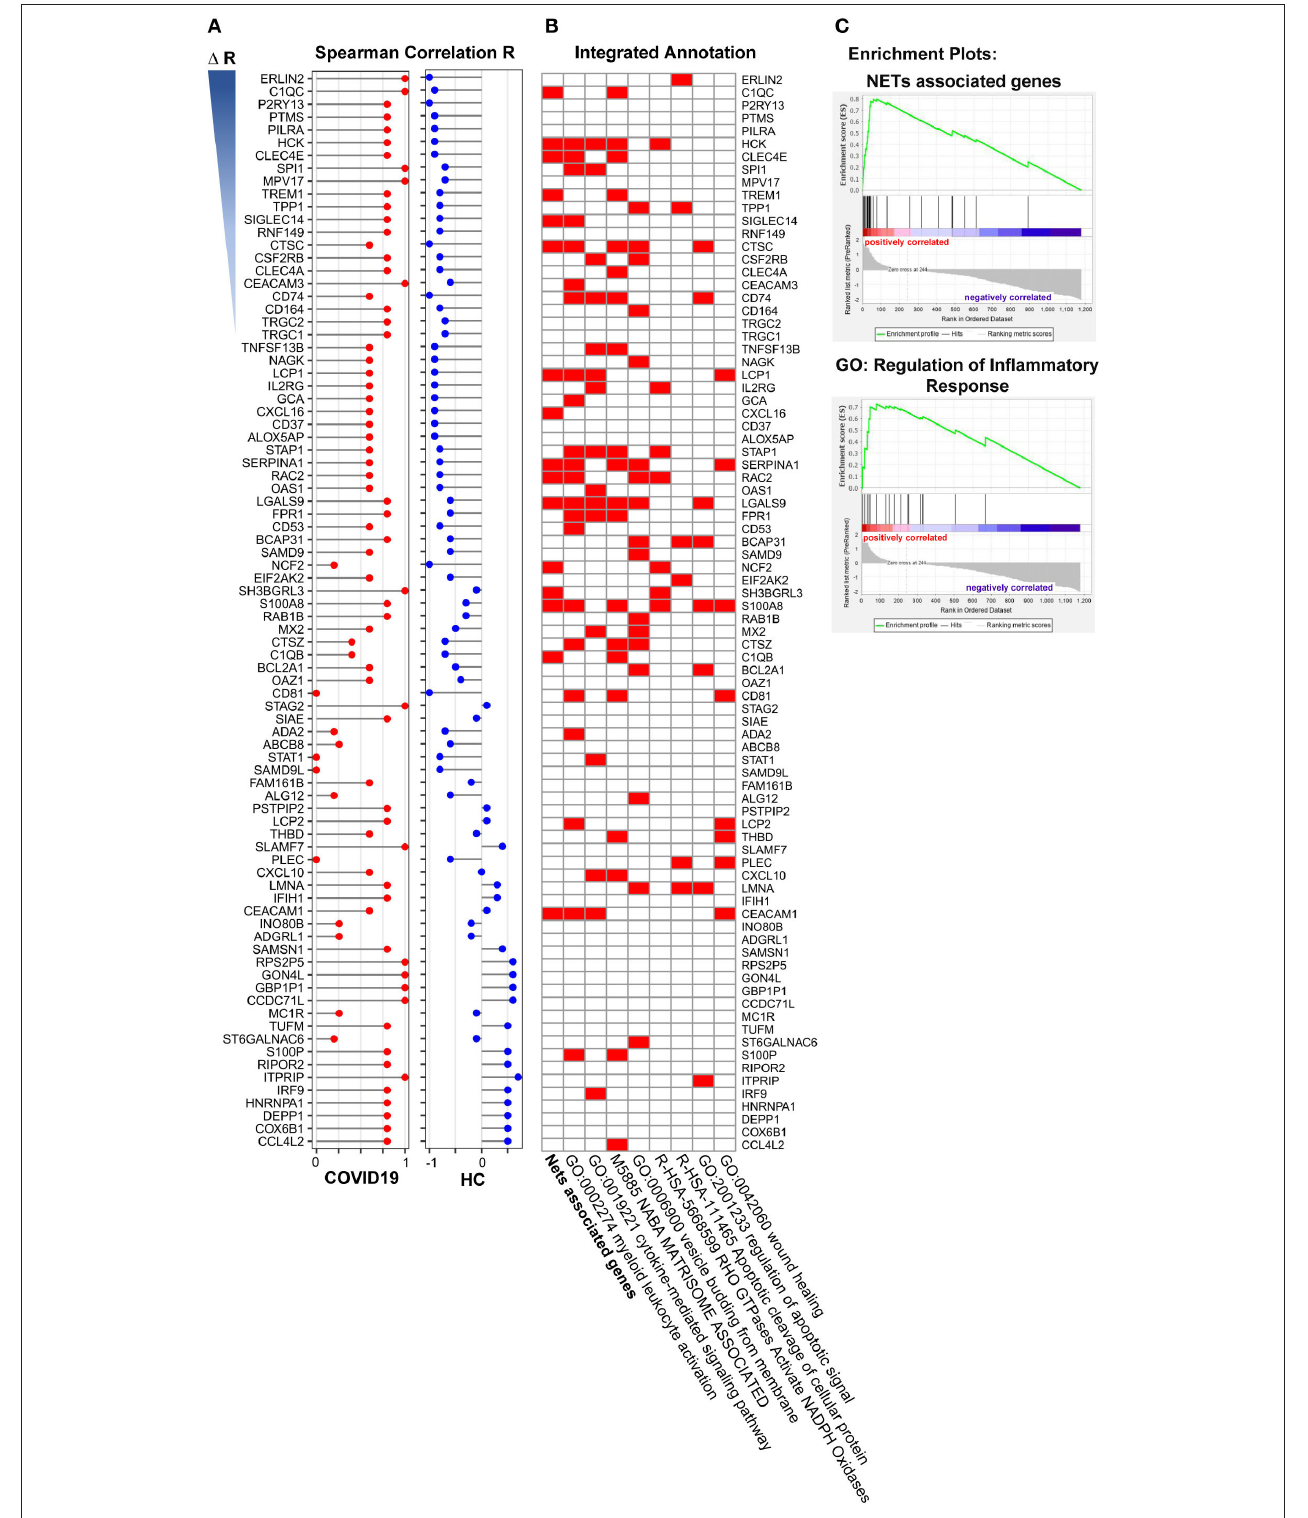
FIGURE 5 | Gene enrichment analysis of neutrophil activation related genes. (A) The 15 annotated genes of neutrophils activation were calculated the average expression of every single samples as neutrophils activation score, and the correlation of the score with overlapped 1,363 differently expressed genes both in COVID-19 and Healthy control were analyzed. The selected 84 genes were ranked based on 1 R (R1-R2, R1 from COVID-19 patients, R2 from healthy control). (B) Functional enrichment analysis of these 84 genes, of which 16 genes were NETs associated genes. (C) Nets associated genes set (Enrichment Score, 0.80) and the GO term of regulation of inflammatory (Enrichment Score, 0.72) by GSEA with DEGs from pre-ranked by 1 R.